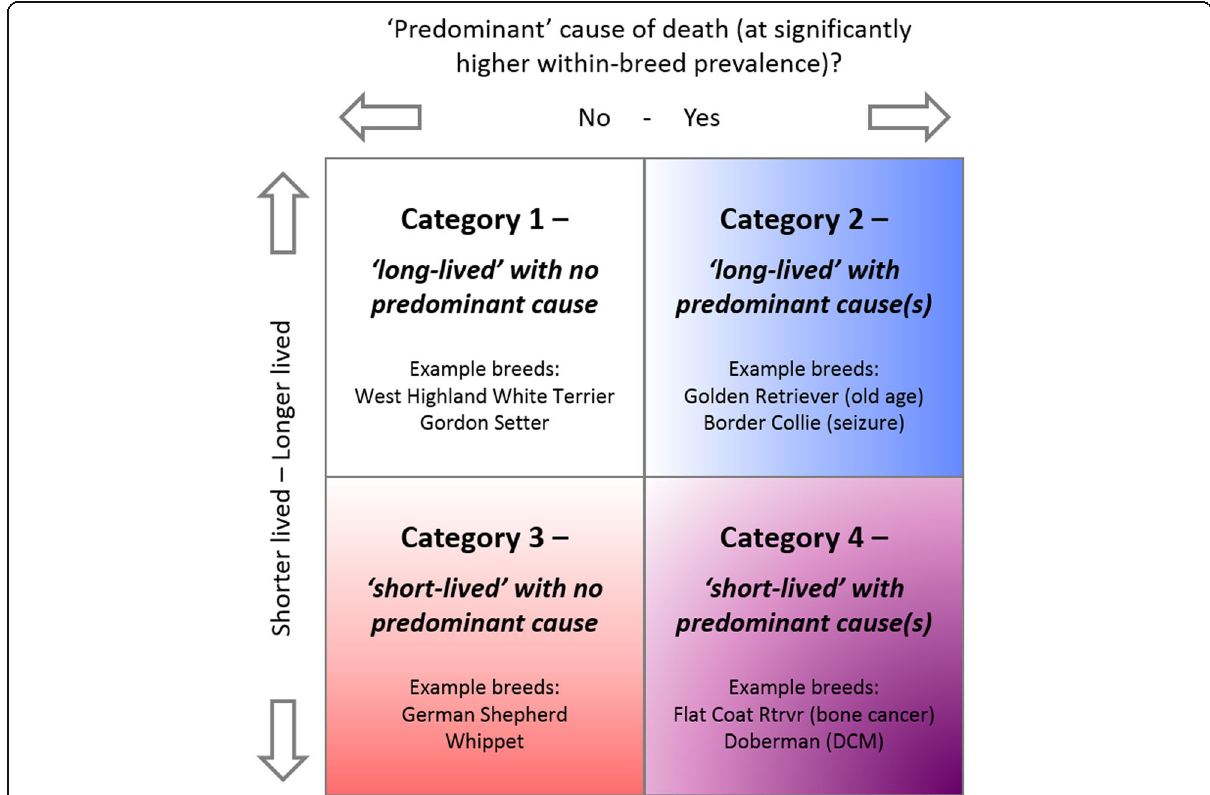
Fig. 5 Diagrammatic representation of the 4 categories breeds may be assigned to based on longevity and high within breed prevalence of particular cause(s) of death. Longer and shorter lived (red) shown on vertical; binary category on horizontal indicating no cause of death at higher within breed prevalence (left) and one or more causes at higher within breed prevalence